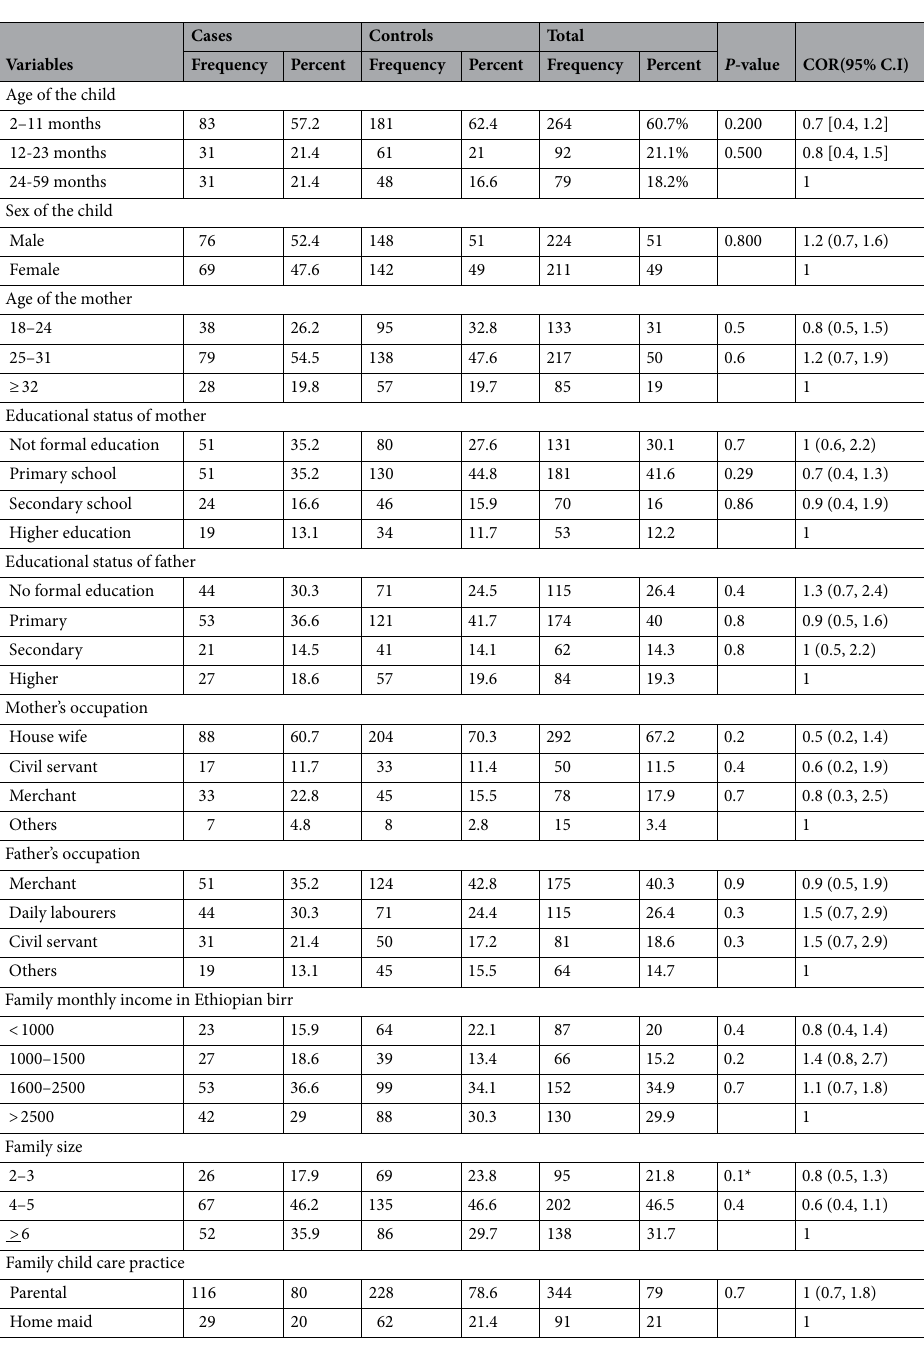
Table 1. Socio-demographic characteristics of children aged 2–59 months attending public health facilities in Worabe town, Silte zone, 2017(N = 145 cases and 290 controls). COR crude odds ratio, CI confidence interval, 1 reference